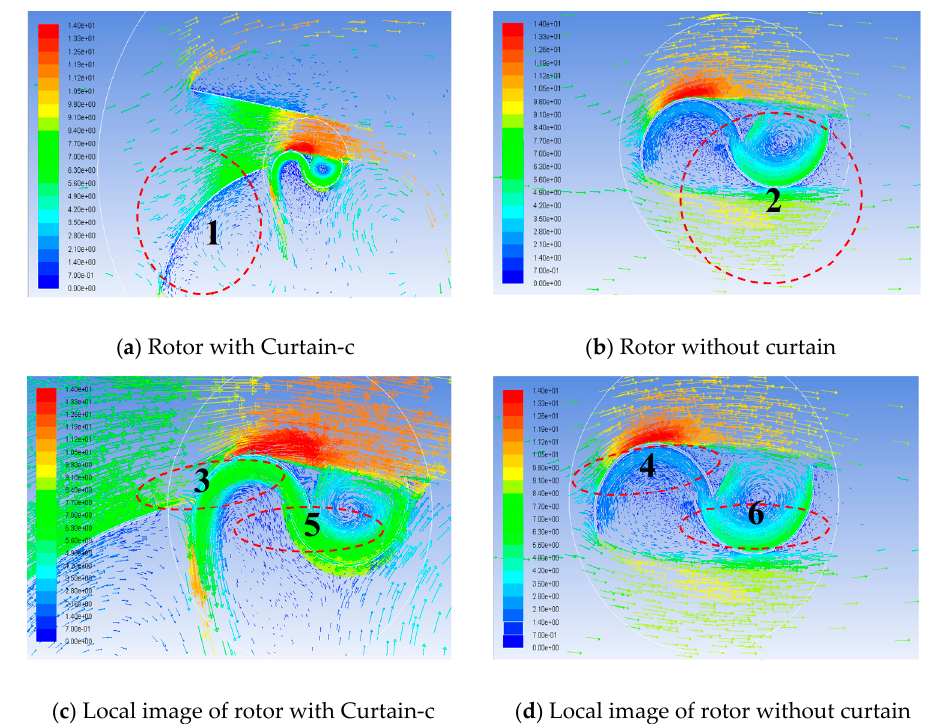
Figure 21. Comparison of the velocity contours for the wind rotor ( a ) with Curtain-c, ( b ) without the curtain and their corresponding local images ( c , d ) at θ = 165°.